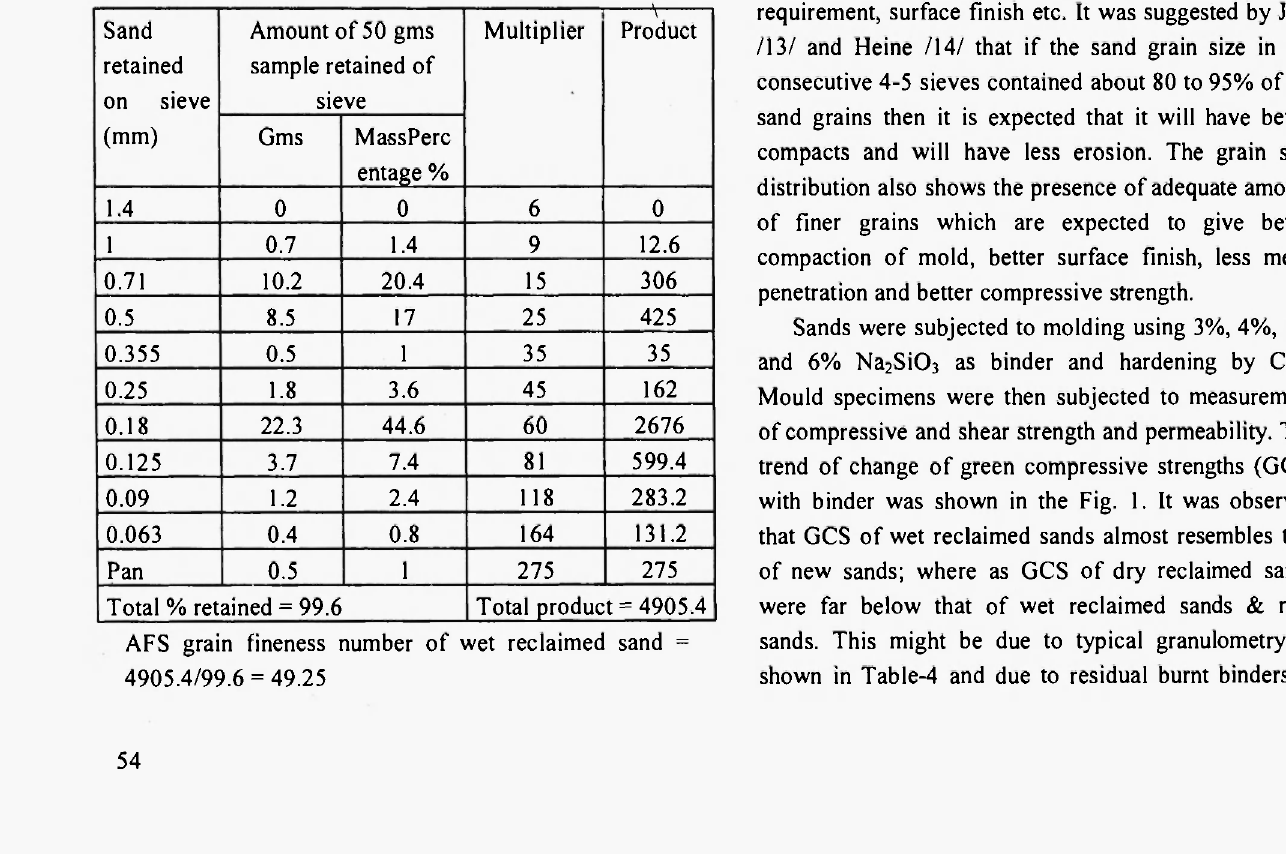
Calculation of AFS grain fineness number of